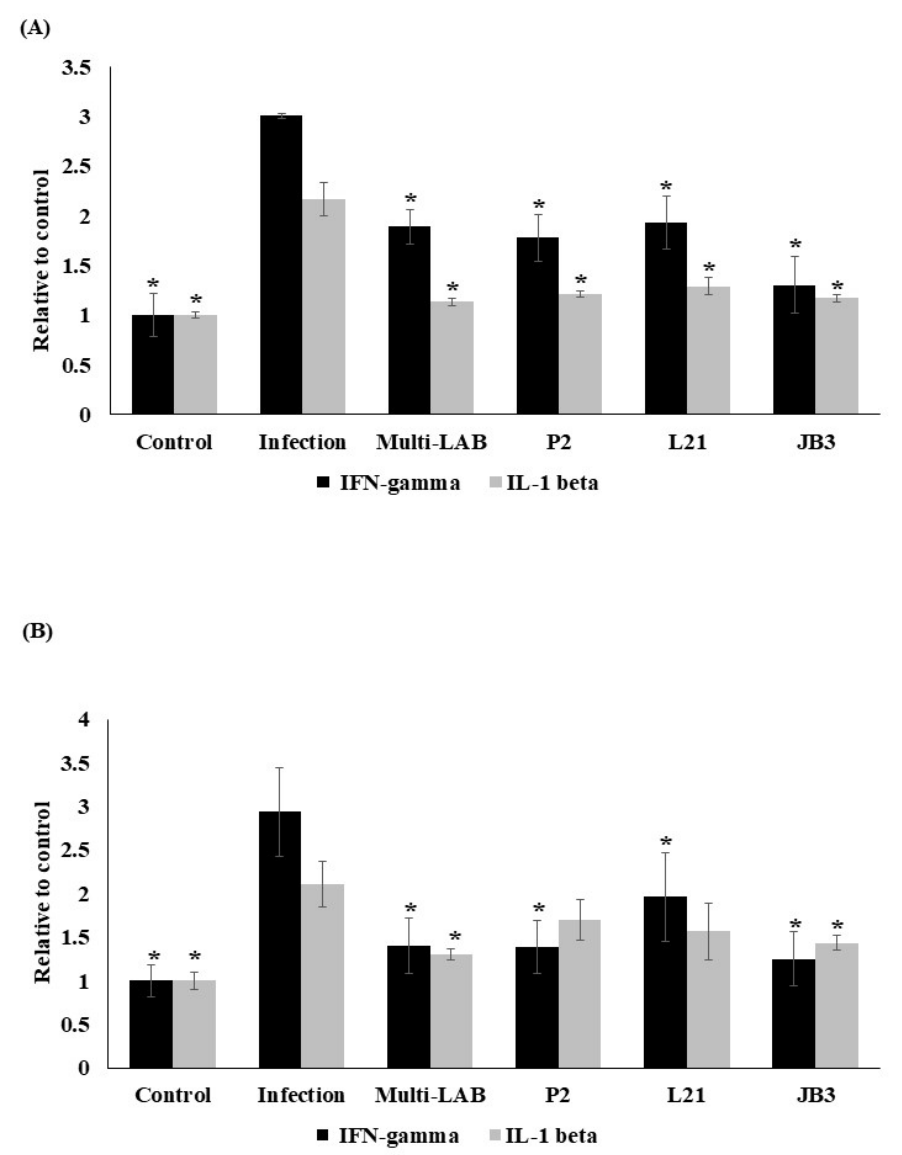
Figure 3 . Effects of LAB strains on IFN-gamma and IL-1 beta levels in in serum ( A ) and stomach homogenates ( B ) of mice. * Means significantly different from infection group, p < 0.05.